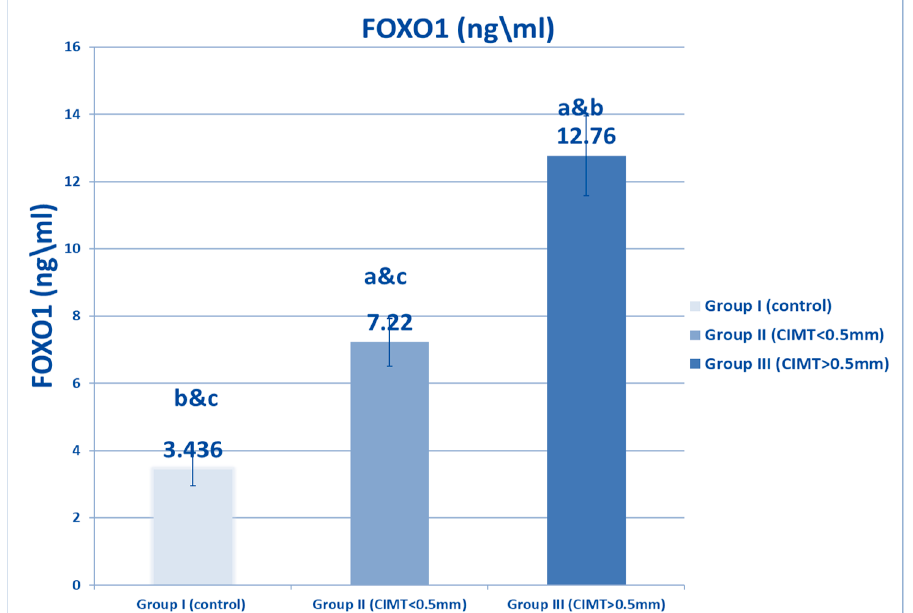
Figure 2. Comparison between studied groups with regard to FOXO1 level. Data are represented as mean ± SD ( n = 50 in each group). Statistical analysis was carried out using one-way ANOVA with Tukey’s post hoc test, SPSS computer program. a–c: Significant difference between groups at * p < 0.05. a: significance from Group I; b: significance from Group II; c: significance from Group III. FOXO1: forehead box protein 1.